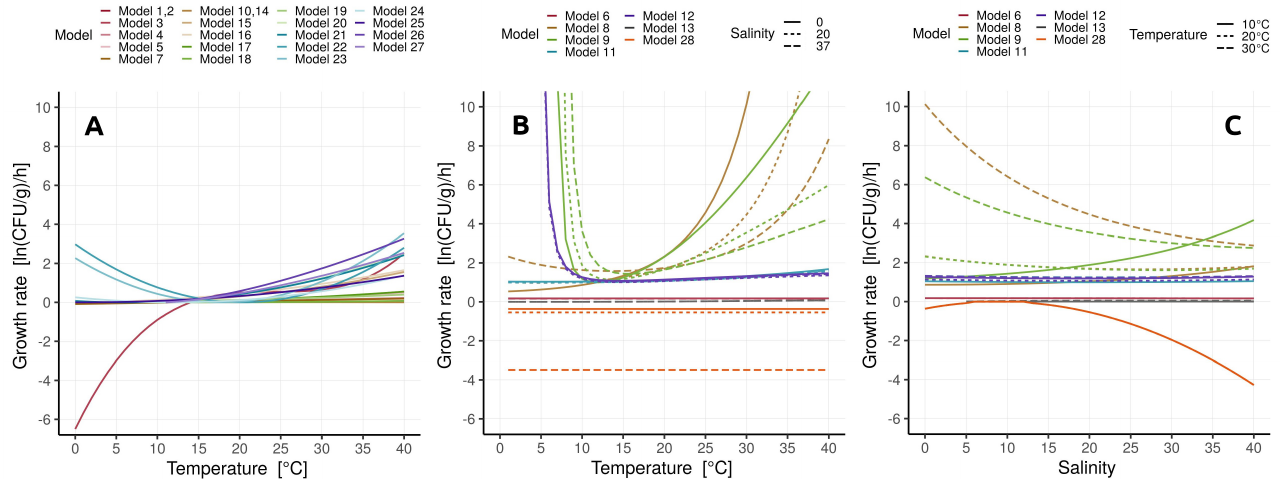
Figure 5. Relationships between growth rate and environmental variables as predicted by secondary models. The models in panel ( A ) include only a temperature correction. Panel ( B ) shows dependence of growth rate on temperature for three salinity levels. Panel ( C ) shows dependence of growth rate on salinity for three temperatures. A pH value of 8.1 was assumed for Model 6. Model 28 had a flat temperature response because it used the default parameter value [49] that minimized temperature correction, θ = 1; increasing θ would increase the temperature